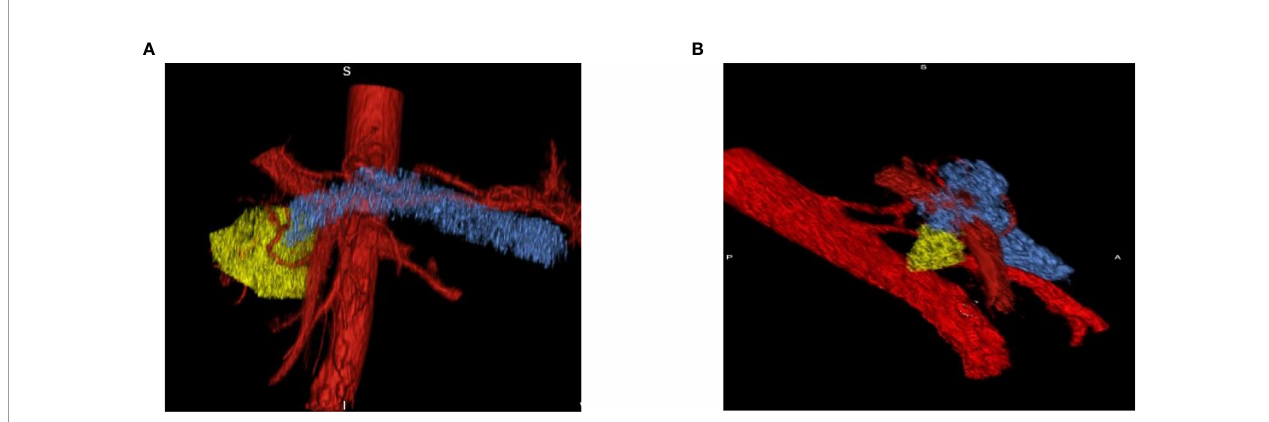
FIGURE 8 | Pre- and Post-Treatment Tumor. (A) Pre-treatment tumor surrounded by vessels which indicates the increase in perfusion effect in tumor progression. (B) Post-treatment tumor volume decreases on the follow-up scan which shows that decreases in perfusion lessens the aggressiveness of the tumor.